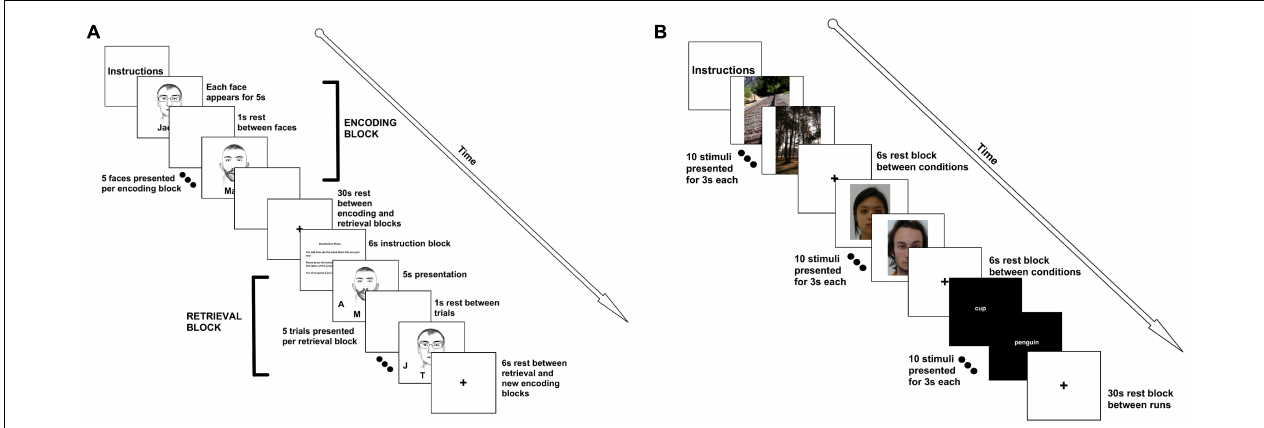
FIGURE 1 | FMRI tasks. (A) For the face-name paired associate task, participants were presented with 5 faces. Each face was presented for 5 s with a 1 s interstimulus interval. This constituted an “encoding” block. A 30 s rest period followed the encoding block. Then, participants were given a 6 s instruction slide indicating that they would now need to recall the names of the faces. Participants were then given each of the faces, with initials underneath them. The participant had to select the correct initial using a button box. Faces and distractor initials were randomized. An encoding and retrieval block together constituted a run, and we completed 6 runs for a total of 30 face-name pairings. (B) For the encoding and recognition tasks, participants were presented with 10 scenic pictures (each picture was presented for 3 s), followed by a 6 s rest. Participants were then shown 10 faces, with a 6 s rest, followed by 10 words. This constituted a run. There was a 30 s rest between runs. Faces, words, and pictures were the same for all 3 of the runs. The recognition task followed the same format, but was presented at the end of the scan, approximately 45 min later. For the recognition task, participants were asked to push the left button if they had seen the face, word, or picture previously, or the right button if it was novel (40% of the stimuli were novel). For both tasks, clustering was performed using block analyses.